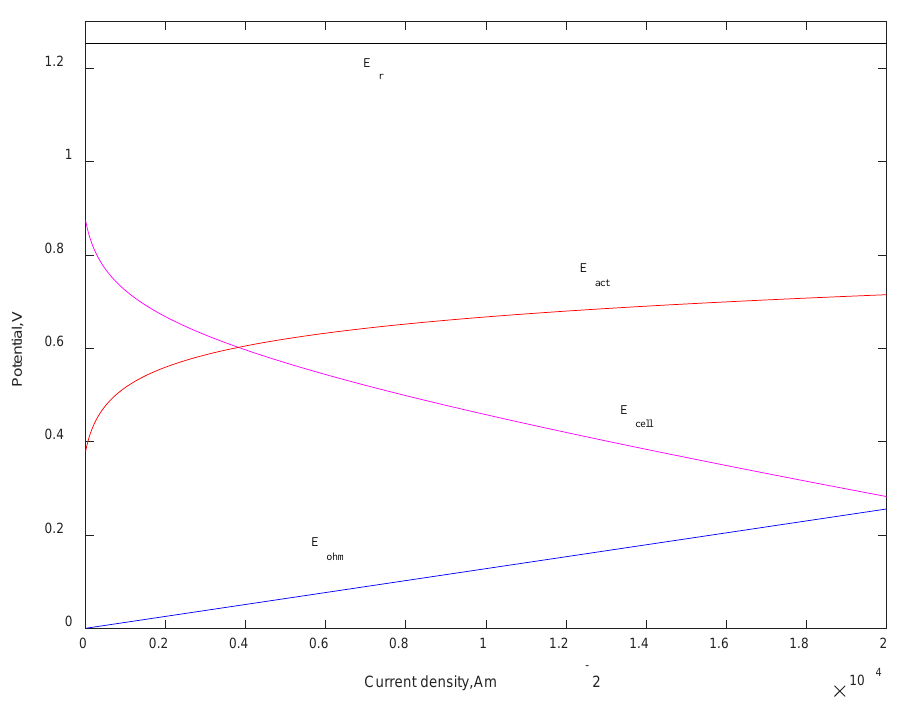
Figure 3. Reversible voltage, polarized overpotential and irreversible output voltage of HT-PEMFC. Figure 3 shows the variation curve of reversible voltage, polarized overpotential and irreversible output voltage versus current density of HT-PEMFC. It can be seen that the reversible voltage is a constant independent of current density. The activation overpoten- tial and ohm overpotential increase with the increase of current density, and the activation overpotential changes greatly in the area of low current density. The irreversible output voltage decreases as the current density increases.